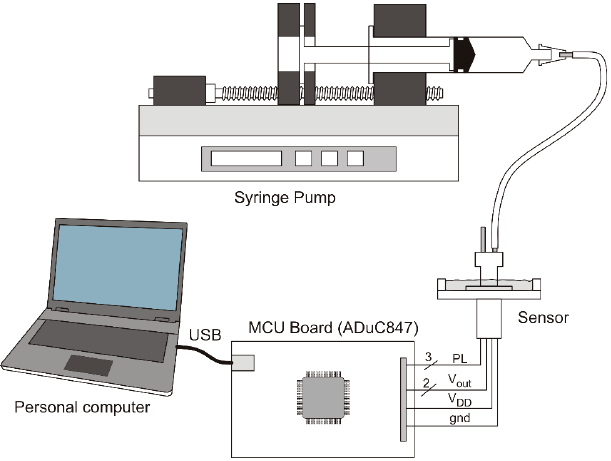
Figure 5. Measurement setup used for the volumetric measurements.